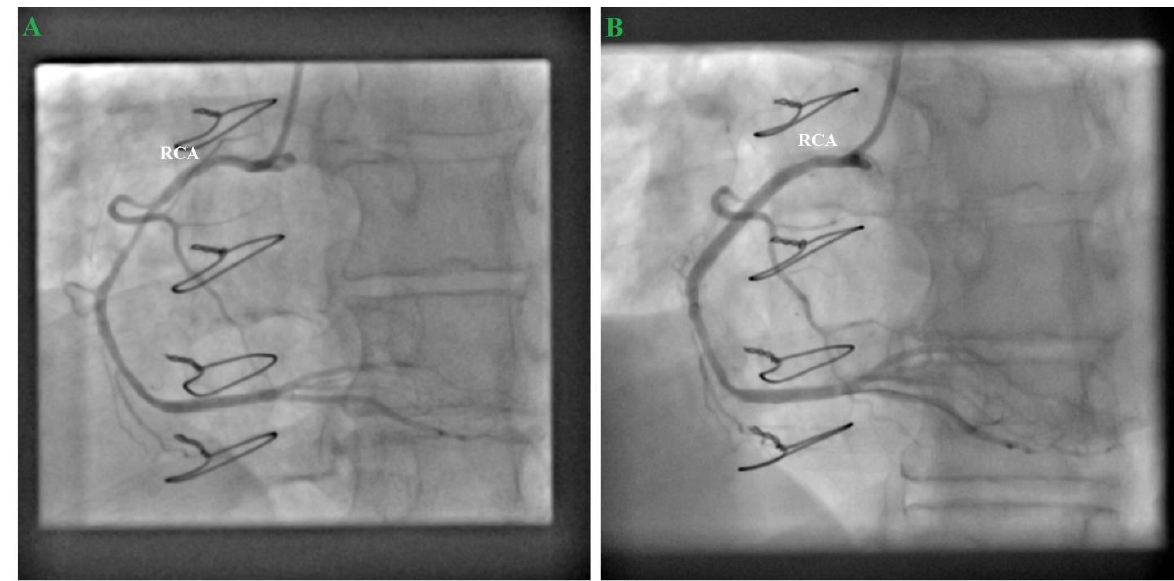
Figure 5. ( A ): Cranial projection of the right coronary artery (RCA) showing, at diagnosis, that the internal saphenous vein graft to the RCA was totally occluded this time around; ( B ): Drug-eluding stent angioplasty on the RCA mid segment, TIMI 3 flow.